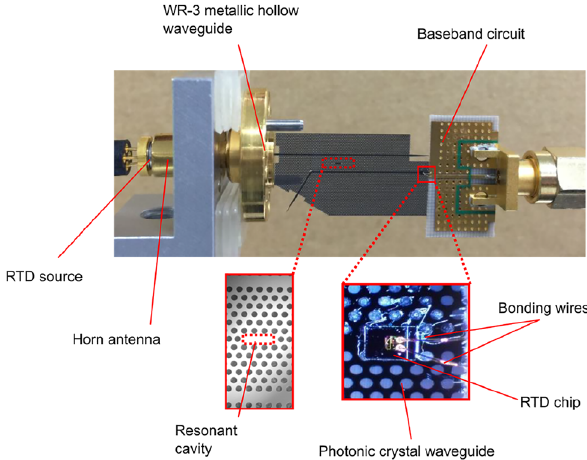
Figure 3: Terahertz sensor realized in all-Si platform. Photonic crystal cavity acts as sensor. This device is representative of the 1G THz integrated